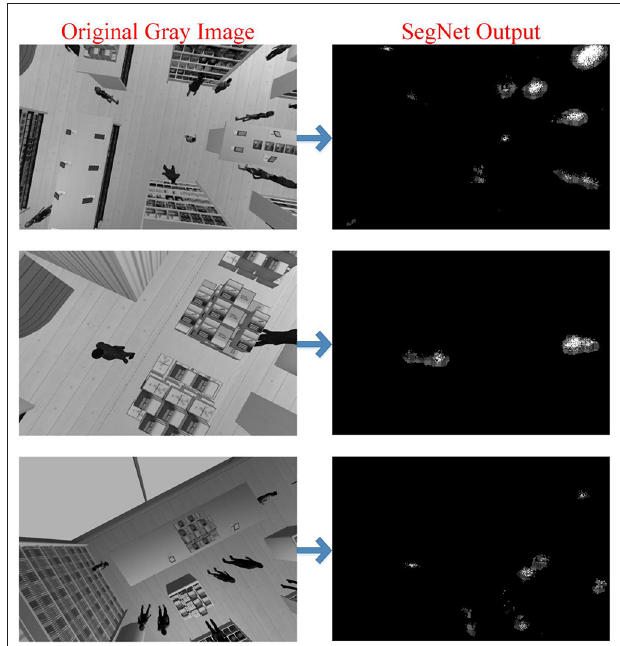
FIGURE 11 | Some frames of the Shopping Malls Dataset (Original Gray Image) and semantic human masks obtained as a result of feeding these frames to the trained SegNet (SegNet Output).